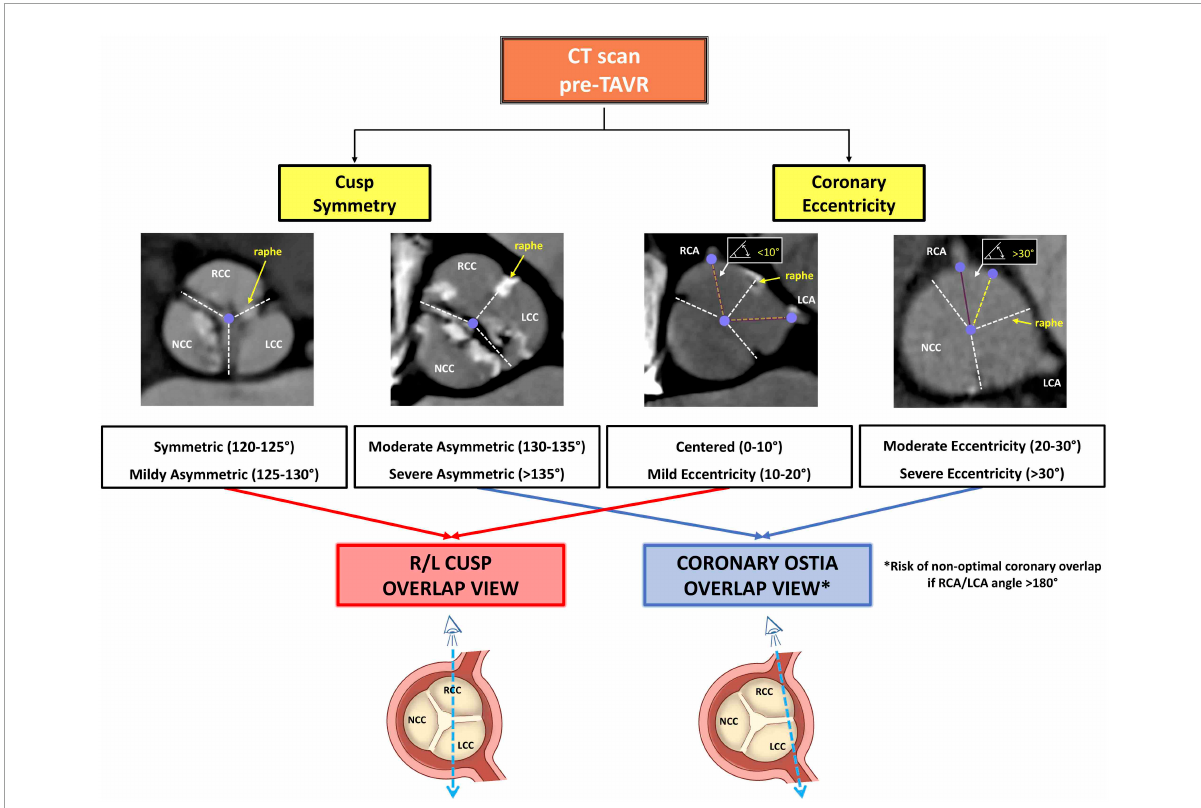
FIGURE6 Illustration of the flow algorithm when evaluating pre-procedural CT scan to customize THV alignment in BAV. CT, computed tomography; THV, transcatheter heart valve; BAV, bicuspid aortic valve; TAVR, transcatheter aortic valve replacement; R, right; L, left; RCA, right coronary artery; LCA, left coronary